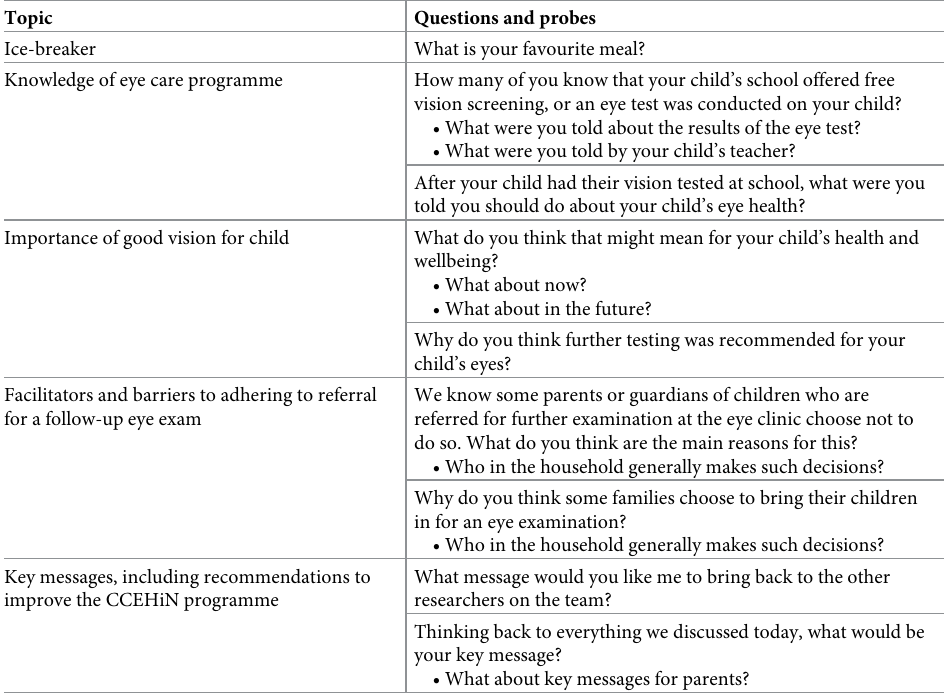
Table 1. Focus group interview